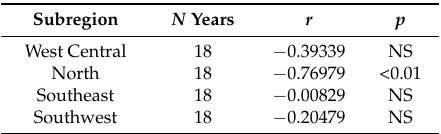
Table 8. Spearman rank correlations of trend (abundance vs. year) at Buena Vista Grassland by geography. This is for the period 1998–2015 (maximum number of years possible while keeping number of years constant among areas). NS = not significant ( p >